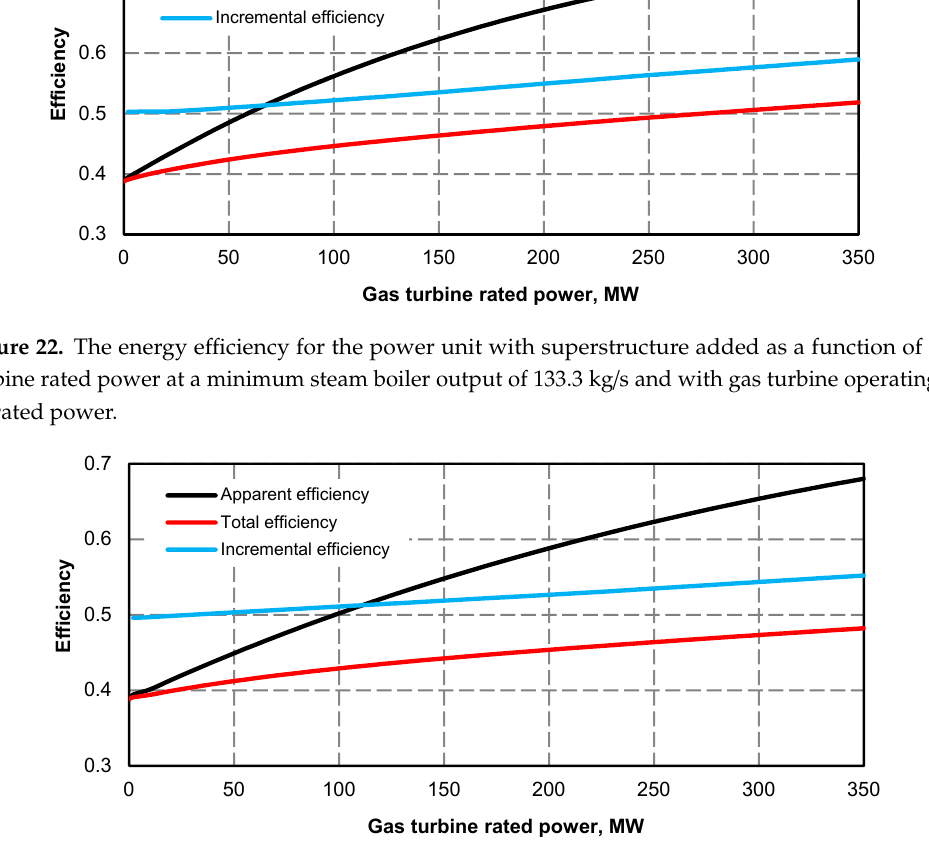
Figure 23. The energy efficiency for the power unit with superstructure added as a function of gas turbine rated power at a minimum steam boiler output of 133.3 kg/s and gas turbine operating at 60% of its rated power.